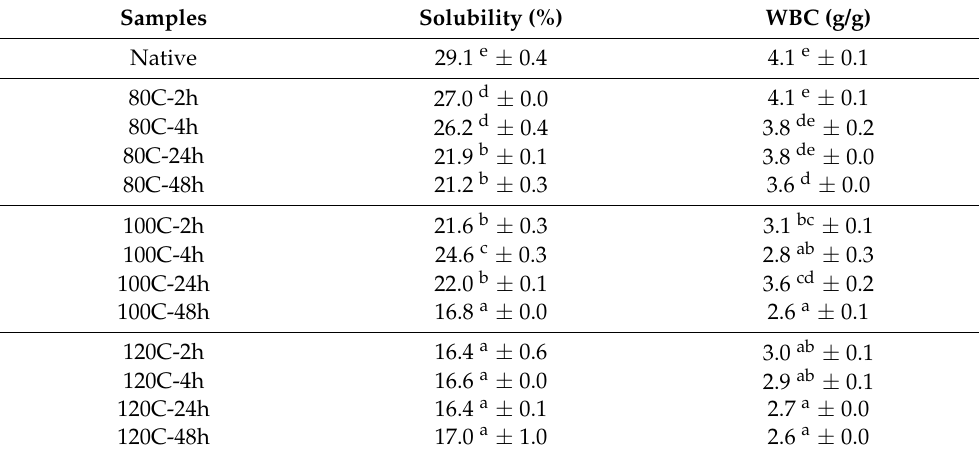
Table 1. Solubility and WBC of native and dry-heated CPF. For the dry-heated CPF samples, the temperature (C) and time (h) treatment conditions are indicated by the codes. Samples Solubility (%) WBC (g/g)